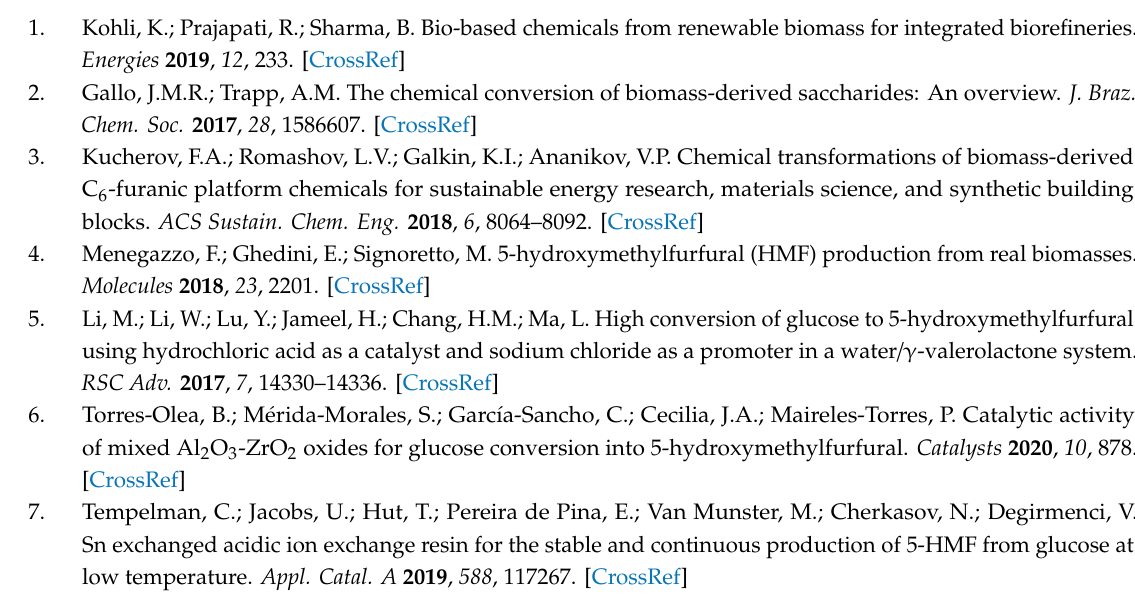
Figure S1: Particle size distribution of: (a) the synthesized bare Beta, (b) the in-situ synthesized Sn incorporated Beta (0.4 wt% Sn-Beta), (c) the commercial Beta (Beta-COM), and (d) the conventional ZSM-5 (ZSM-5-CON), Figure S2: N 2 adsorption / desorption isotherms of (a) the synthesized bare Beta, and (b) the in-situ synthesized Sn incorporated Beta (0.4 wt% Sn-Beta), Figure S3: NH 3 -TPD profiles of (a) the synthesized bare Beta, (b) the in-situ synthesized Sn incorporated Beta (0.4 wt% Sn-Beta), (c) the commercial Beta (Beta-COM), and (d) the conventional ZSM-5 (ZSM-5-CON), Figure S4: (A) XRD pattern (B) SEM image, (C) Particle size distribution and (D) NH 3 -TPD profile of the commercial ZSM-5 (ZSM-5-COM) zeolite. Table S1: Chemical compositions analyzed by XRF of the synthesized bare Beta, the in-situ synthesized Sn incorporated Beta (0.4 wt% Sn-Beta), the commercial Beta (Beta-COM), and the conventional ZSM-5 (ZSM-5-CON), Table S2: Brønsted / Lewis acid site ratio was calculated by integrated area of main peaks, Table S3: Acid sites density of all samples determined via the ammonia temperature-programmed desorption (NH 3